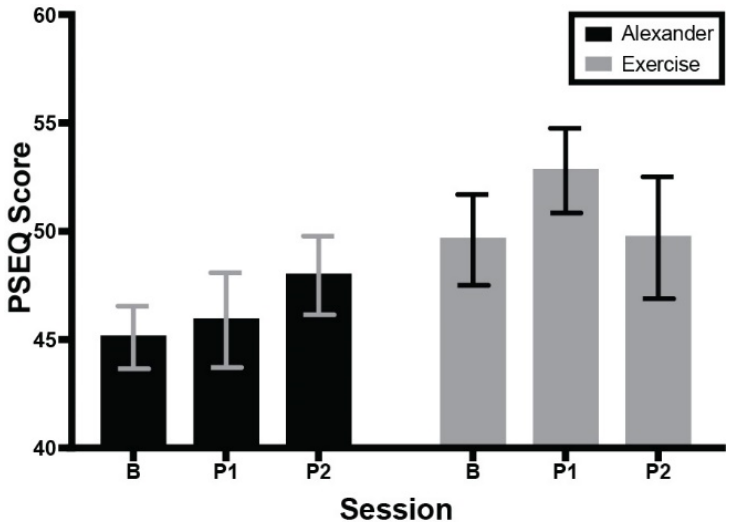
Figure 4. Score on Pain Self-Efficacy Questionnaire (PSEQ) across groups and testing sessions. Higher score indicates higher self-efficacy. Errors bars are the standard error of the mean. B = baseline; P1 = 1st post-test; P2 = 2nd post-test.